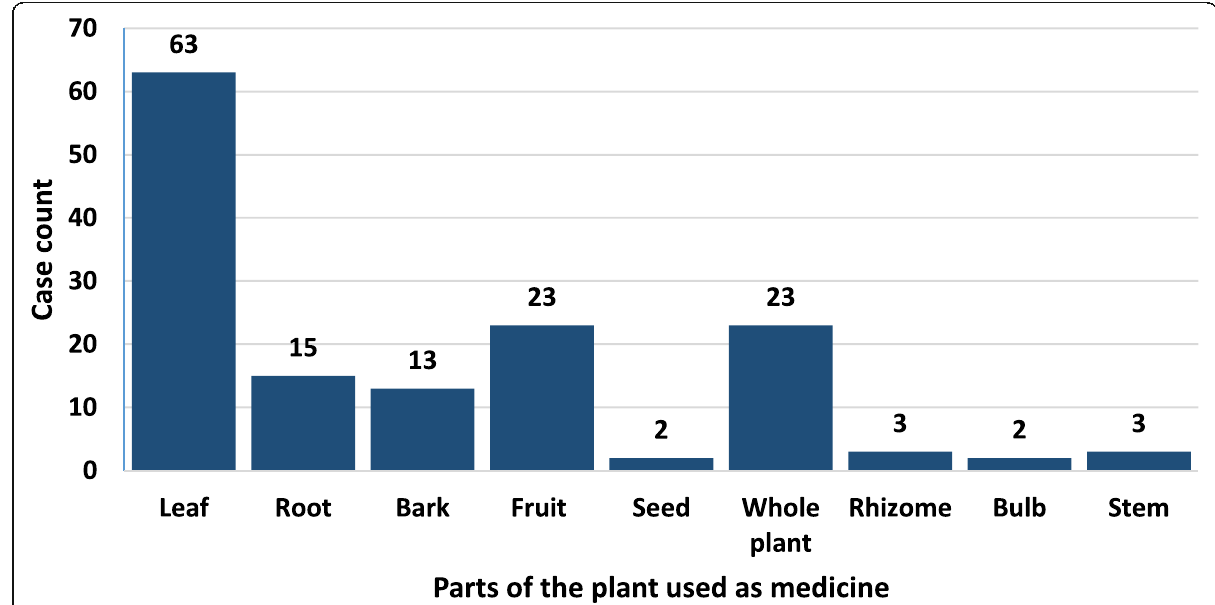
Fig. 1 Part of the plant used as medicines. The most used part of the plant was leaves (42.86%) and the least used parts were the seed and bulb